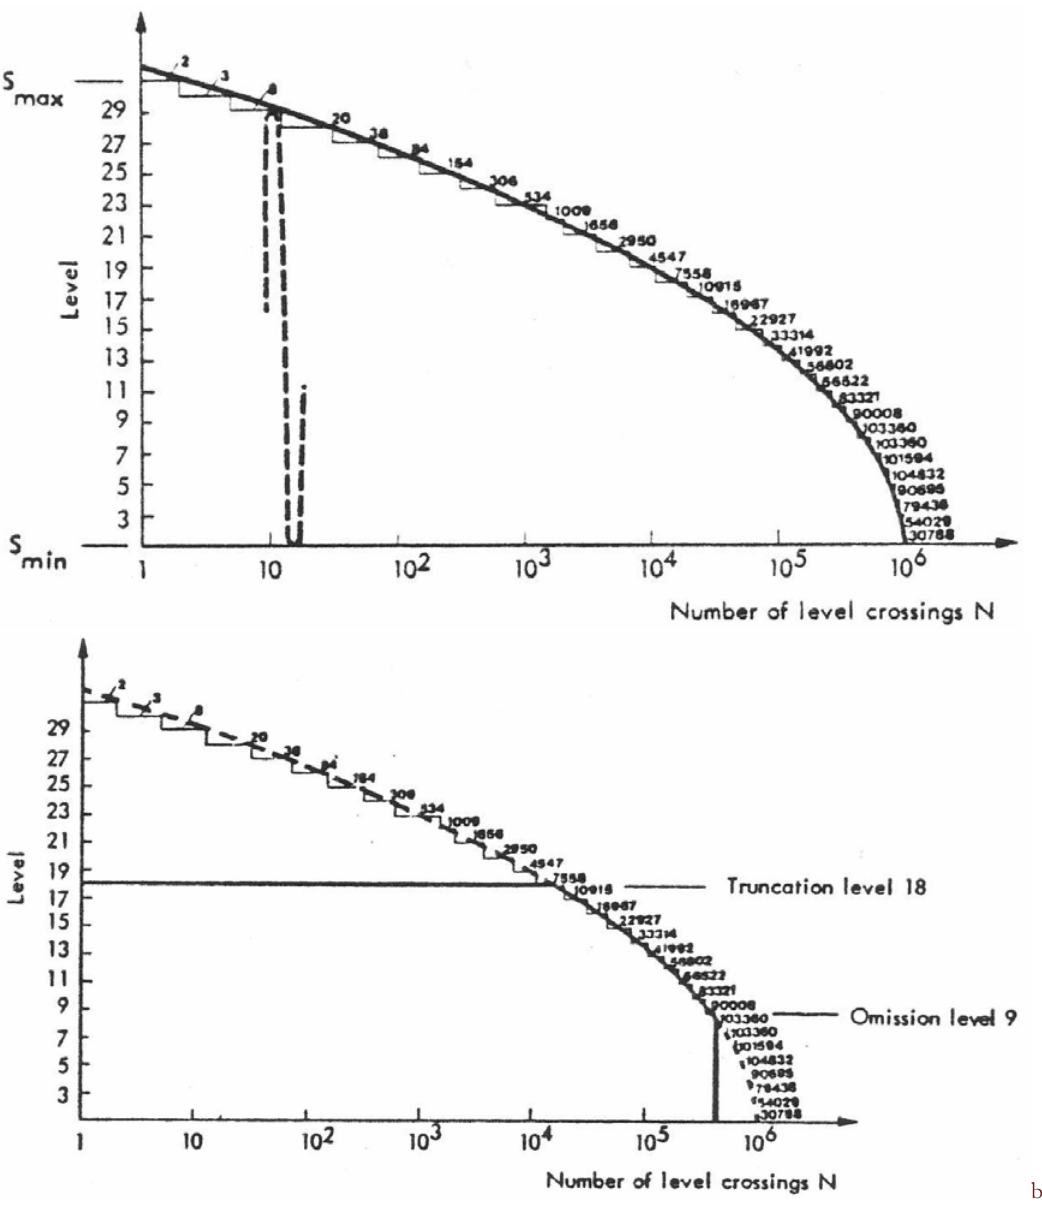
Figure 3: Holmen’s load collectives from [4]: a) Original load histogram consisting in 30 stress steps and b) Loading model 3 with truncation of higher stress amplitudes and omission of lower stress amplitudes applied in the fatigue variable testing